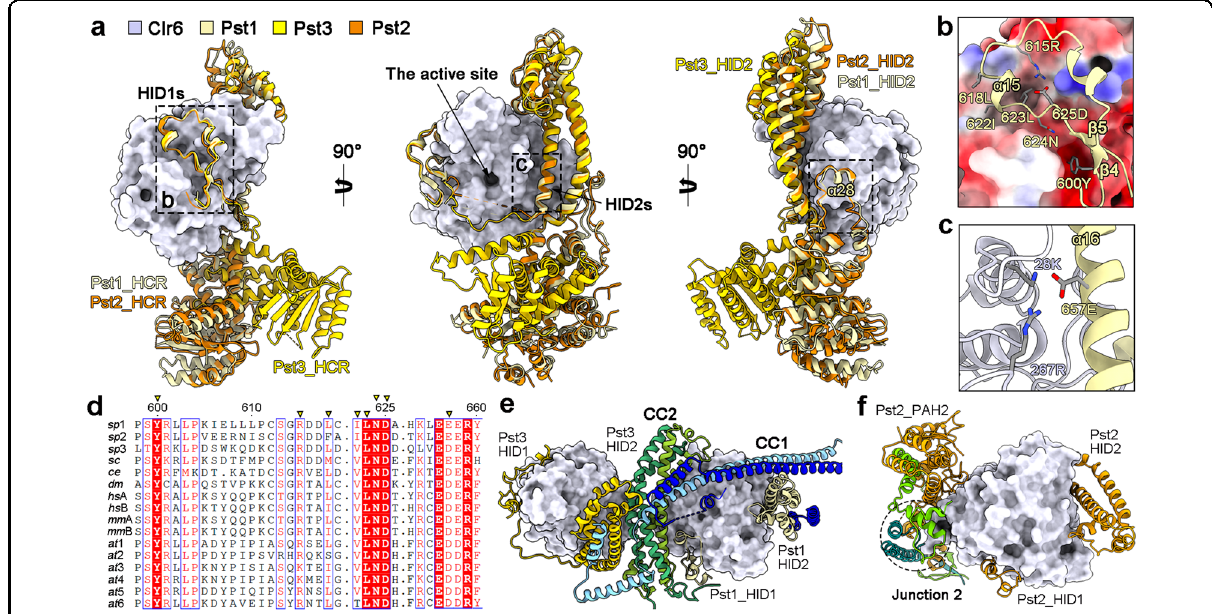
Fig. 4 Stabilization of the Clr6 in the SIN3L or SIN3S complex. a The interactions between Clr6 and the HID of Pst1/2/3. The HID1 and HID2 interact with the Clr6 conservatively. The Clr6 is shown in surface, while Pst1, Pst2 and Pst3 are shown in cartoon. b , c Close-up views of the interface between Clr6 and HID1 ( b ) or HID2 ( c ). d The sequence alignment of Sin3 homologs from different species. sp, Schizosaccharomyces pombe; sc, Saccharomyces cerevisiae; ce, Caenorhabditis elegans; dm, Drosophila melanogaster; hs, Homo sapiens; mm, Mus musculus; at, Arabidopsis thaliana . e , f Clr6 is stabilized by the scaffold of the SIN3L ( e ) or the SIN3S ( f )